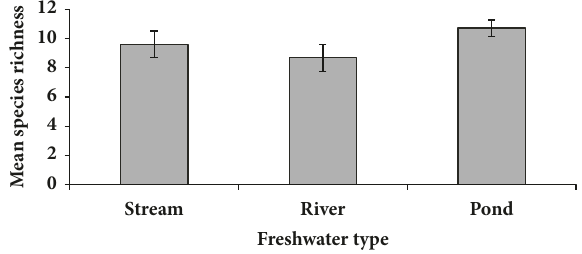
Figure 7: Mean Odonata species richness among the various water types.